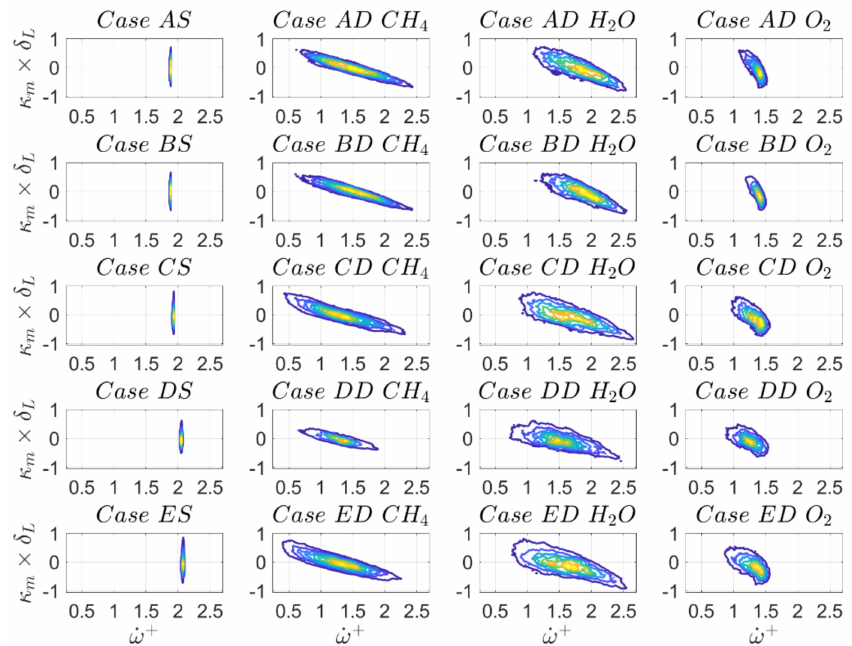
Figure 17. Joint PDF of normalised reaction rate and normalised mean curvature κ m × δ L on c = 0.8 progress-variable isosurface for top to bottom cases A–E for (1st column) SC and (2nd to 4th column) DC simulations for reaction progress variable based on CH 4 , H 2 O,O 2 mass